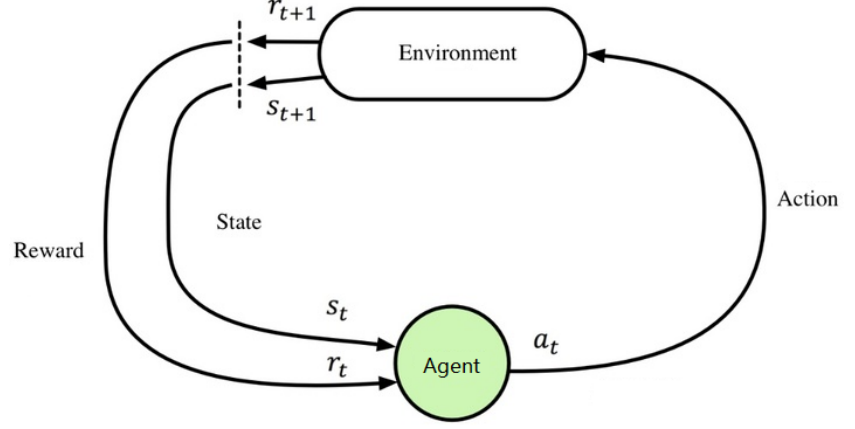
Figure 4. Schematic diagram of the principle of reinforcement learning.